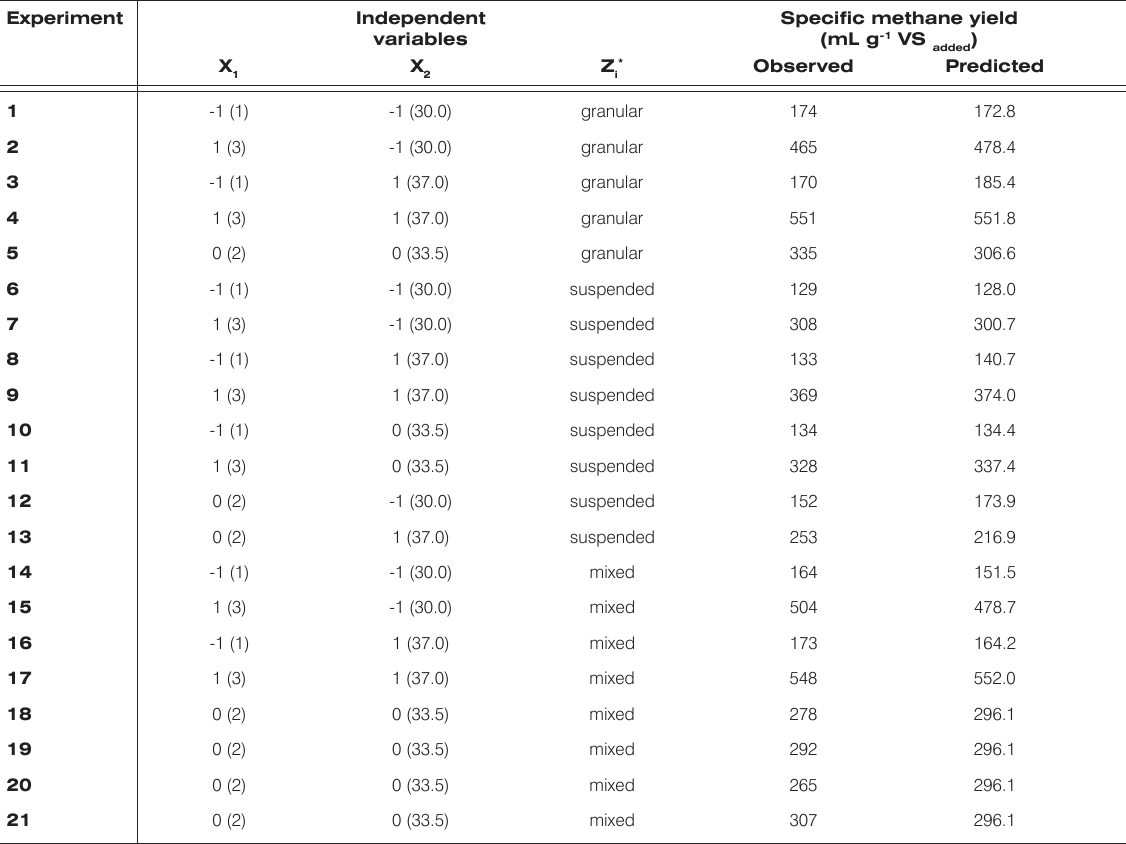
Experiment Independent